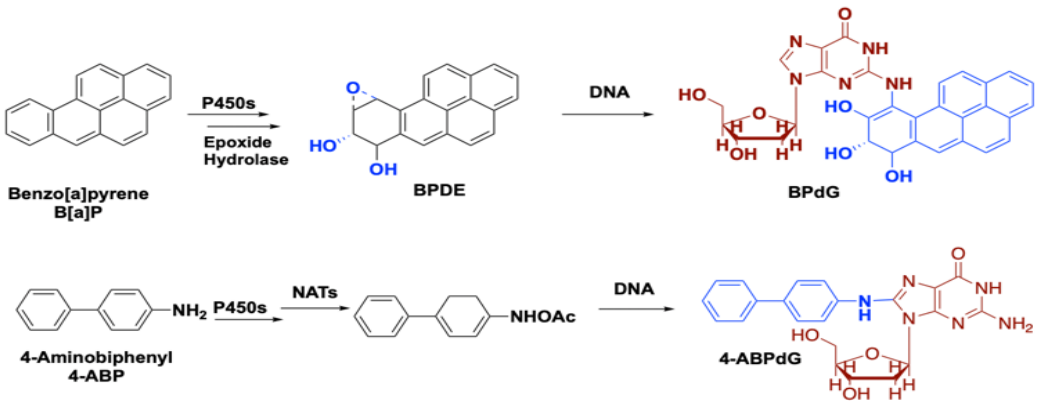
Figure 2. Formation of the DNA adducts by benzo[a]pyrene (B[a]P) and 4-aminobiphenyl (4-ABP).